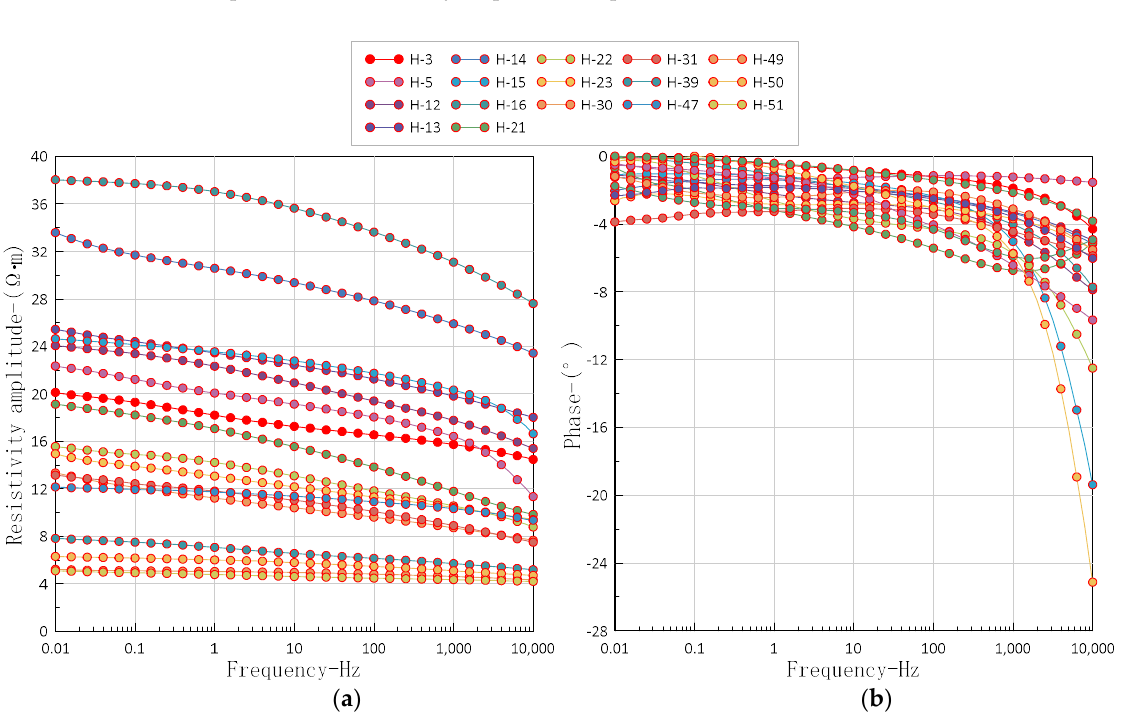
Figure 6. Amplitude and phase diagram of shale resistivity in V direction at normal temperature and pressure. ( a ) resistivity amplitude; ( b ) phase.